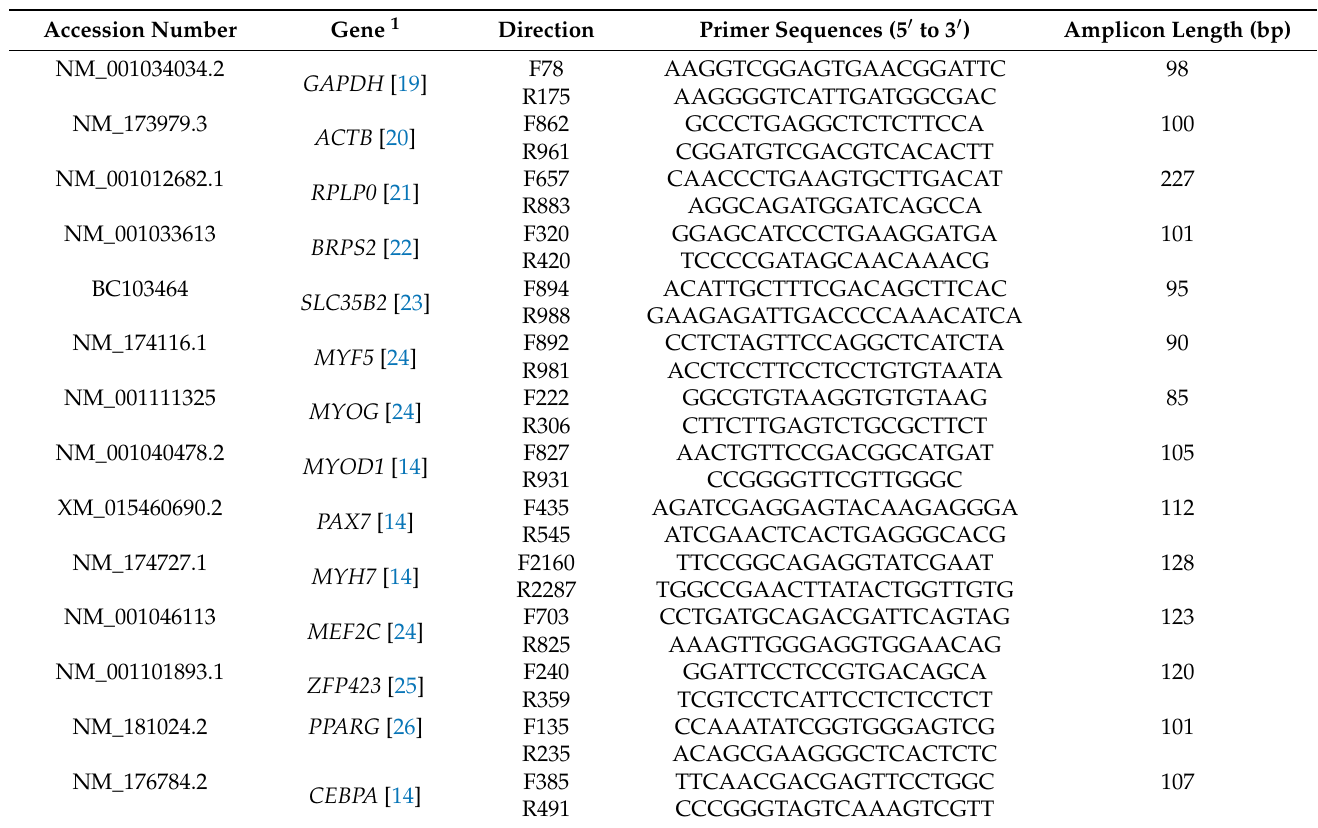
Table 4. GenBank accession number, sequence, and amplicon size of primers used for mRNA expression by